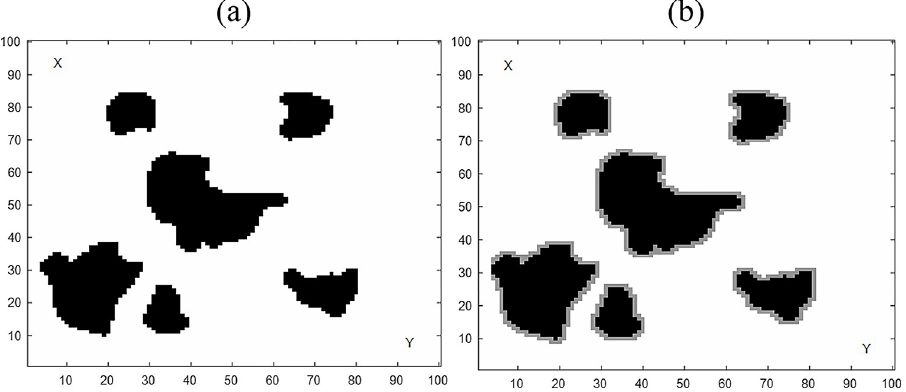
Fig 1. Two-dimensional simulation environment map. (a) Real Environment Map. (b) Safety threshold environment map.